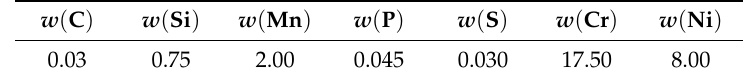
Table 1. Chemical composition specified by GB/T 4237-2015 (weight percentage).